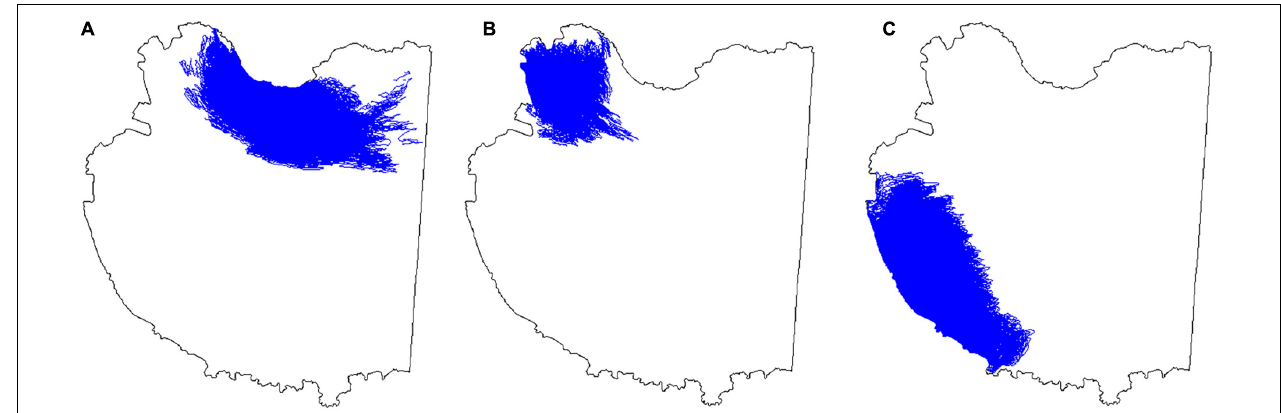
FIGURE 7 | Trajectory of Lagrangian particles in Bohai Bay. (A) Caofeidian Port. (B) Tianjin Port. (C) Huanghua